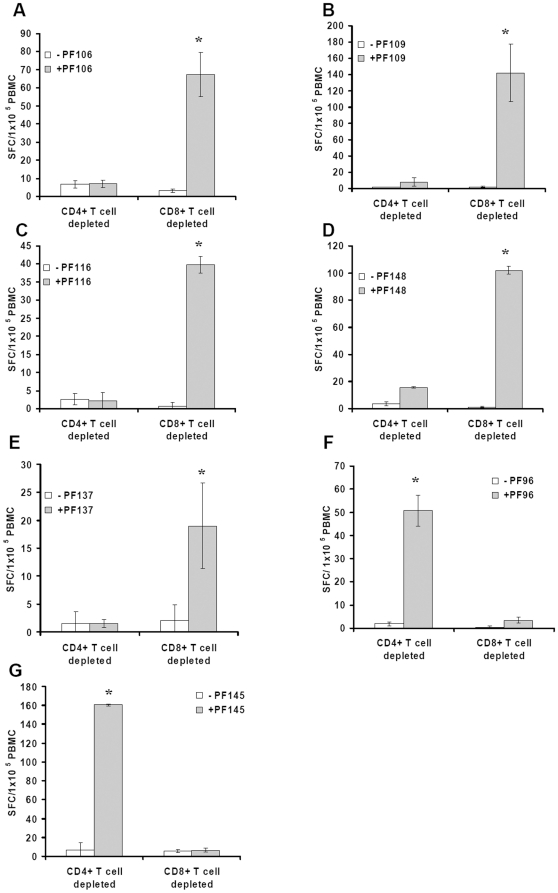
9mer flu-derived peptides induce CD4+ or CD8+ T cell responses.Peripheral blood mononuclear cells (PBMC) obtained from donors 21 (A), 25 (B), 29 (C) 23 (D), 35 (E), 32 (F) and 21 (G) were depleted of CD4+ T cells or CD8+ T cells and incubated with the indicated peptides for 10 days. Prior to testing, cells were harvested, washed and incubated in enzyme-linked immunospot (ELISPOT) plates for 20 h in the absence or presence of the indicated peptides. Results are expressed as the mean spot-forming cell values of four replicate ELISPOT microcultures, each containing 1×105 CD4+ or CD8+ T cell-depleted PBMC. *, P<0.05 (Student's t- test).